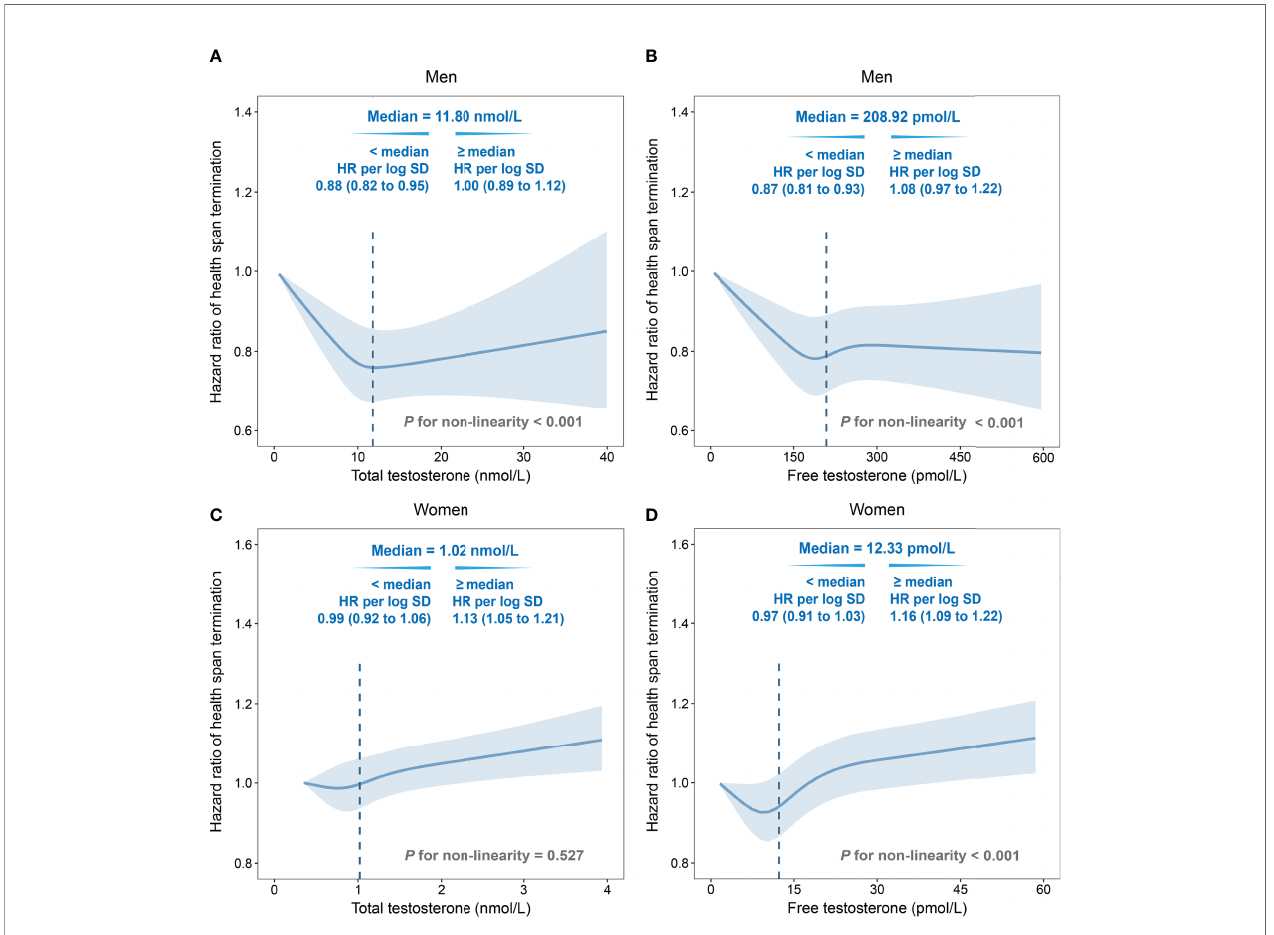
FIGURE 1 | Non-linear associations of total testosterone/free testosterone (TT/FT) with risk of health span termination by multivariate cubic regression splines. (A) TT in men, (B) FT in men, (C) TT in women, and (D) FT in women. Solid lines were point estimation of hazard ratio, and shaded regions represented the 95% CIs. The dotted lines were the median values. Fully adjusted model: age, menopause status (for women), college or university degree, deprivation index, body mass index, smoking status, alcohol drinking, IPAQ group, healthy diet, family history of cardiac-cerebral vascular disease (CCVD) or cancer, use of aspirin/ibuprofen, and hormone replacement therapy (for women). SHBG was additionally adjusted in total testosterone. HR, hazard ratio; SD, standard